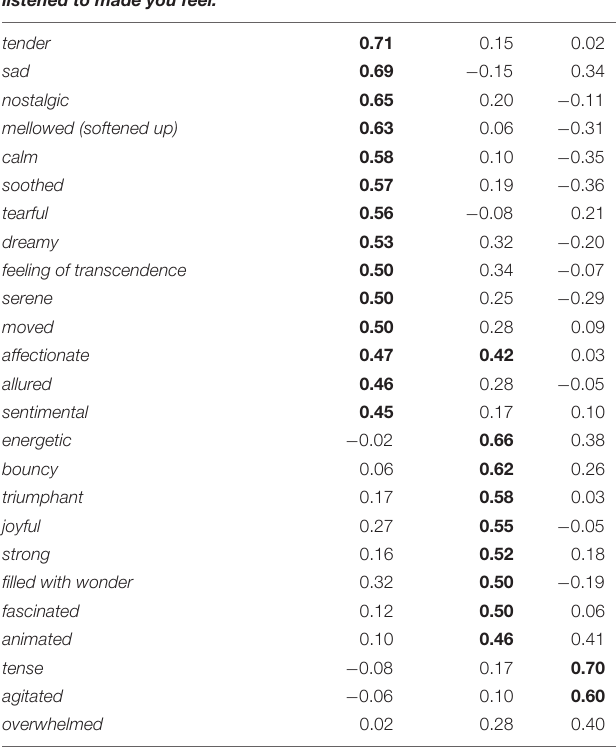
TABLE 6 | Factor loadings for exploratory factor analysis with varimax rotation of subjective feeling items (GEMS-25) from Concert 1. Please describe how the music you listened to made you feel.